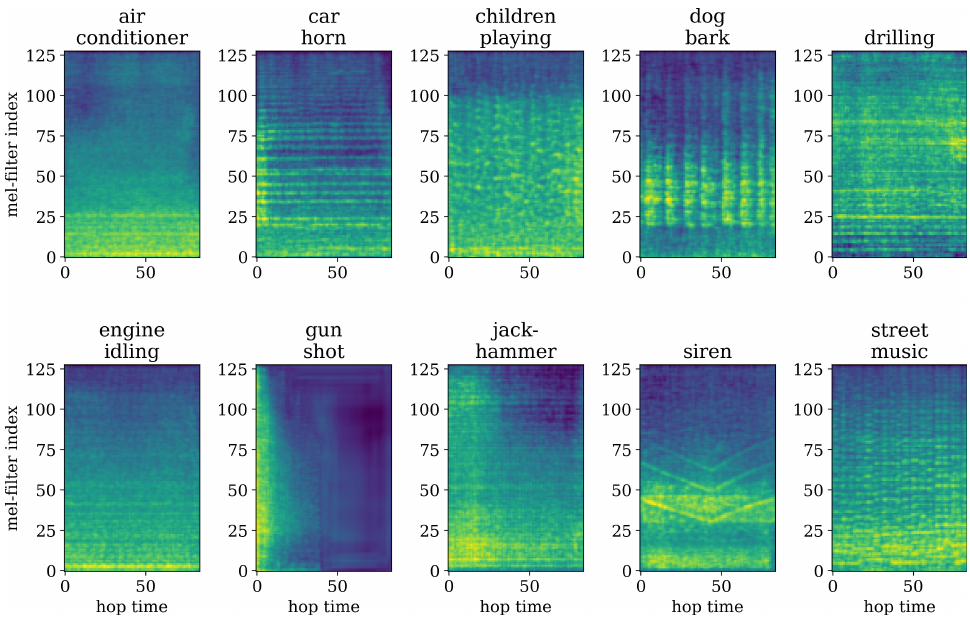
Figure 5. Reconstructed mel-spectrograms of selected prototypes, g p P j q .